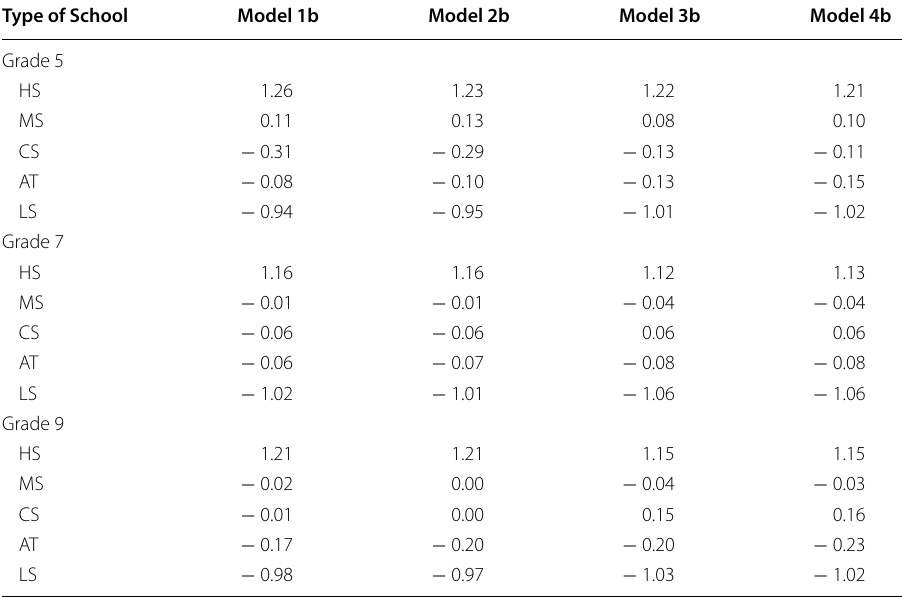
Table 4 Effect sizes (Cohen’s d ) for school type covariates per estimated